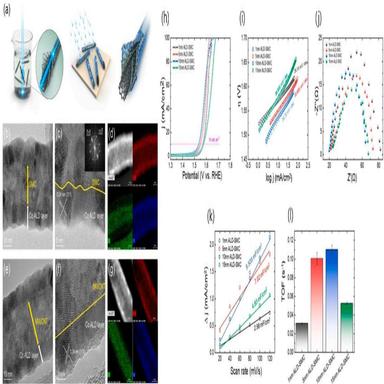
(a) Schematic illustration of the material design concept for 10 nm Co3O4@SMC. (b, c) High-resolution TEM image of 10 nm Co3O4@SMC and the corresponding fast Fourier transformation (FFT) patterns (inset). (e, f) High-resolution TEM image of 10 nm Co3O4@MWCNT. (d) Elemental mapping image of C, Co, and O in as-prepared 10 nm Co3O4@SMC. (g) Elemental mapping image of C, Co, and O in as-prepared 10 nm Co3O4@MWCNT. (h, i) Oxygen evolution reaction (OER) polarization curves (scan rate 5 mV s − 1 ) and correspondi